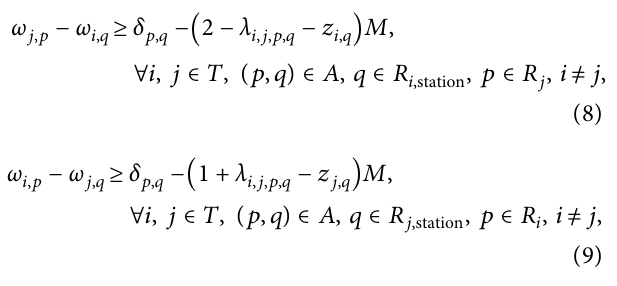
corresponding alternative graph is in the bottom half of Figure 5. As the uncertainty of paths leads the uncertainty of